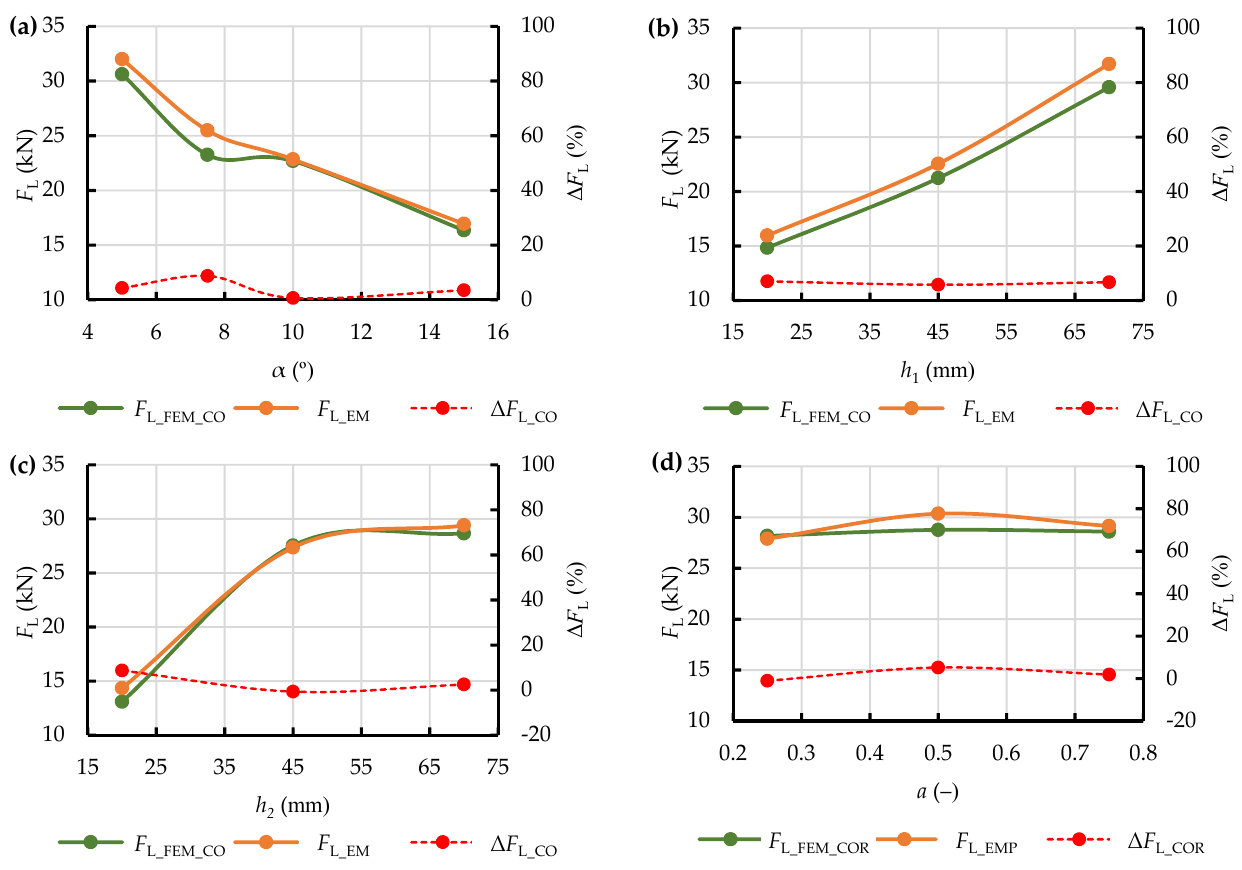
Figure 16. Comparison of the curves representing the relationship of the maximum force during dry ice extrusion and the adopted variable geometric parameters of the analysed single-hole dies for: corrected maximum predicted force ( F L_FEM_COR ), calculated with the corrected yield stress σ pl_COR , maximum observed force ( F L_EMP ), and their percent difference Δ F L_COR for the die groups CS ( a ), WK ( b ), WP ( c ), and WKWP ( d ).